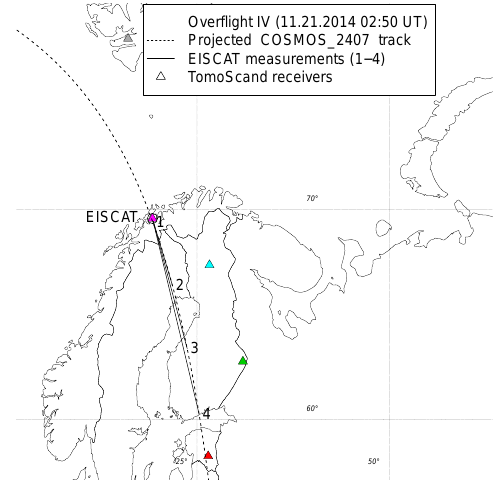
Figure 7. TomoScand receiver network and the satellite overflight ground track with four EISCAT UHF scan